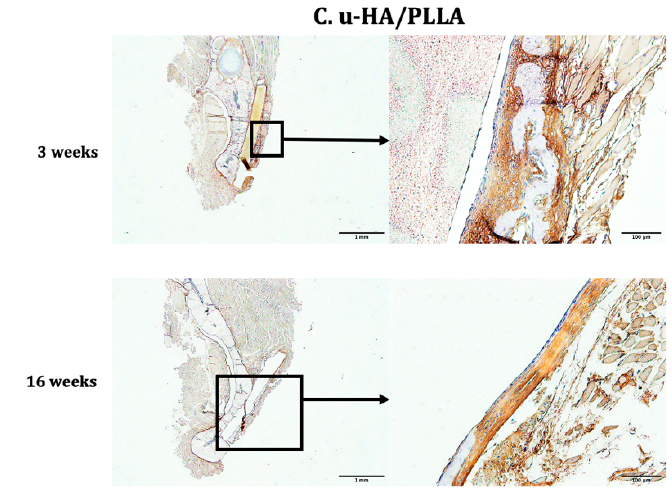
Figure 12. Periostin expression in the u-HA/PLLA/PGA subgroup, u-HA/PLLA subgroup, and sham control. Images in each subgroup were taken at 1.25× and 20× magnification (from left to right). Images of the sham control group were taken at 1.25× magnification. ( A ) u-HA/PLLA/PGA subgroup. ( B ) Sham control group. ( C ) u-HA/PLLA subgroup. Scale bar: 1 mm (1.25× magnification) and 100 μ m (20× magnification).